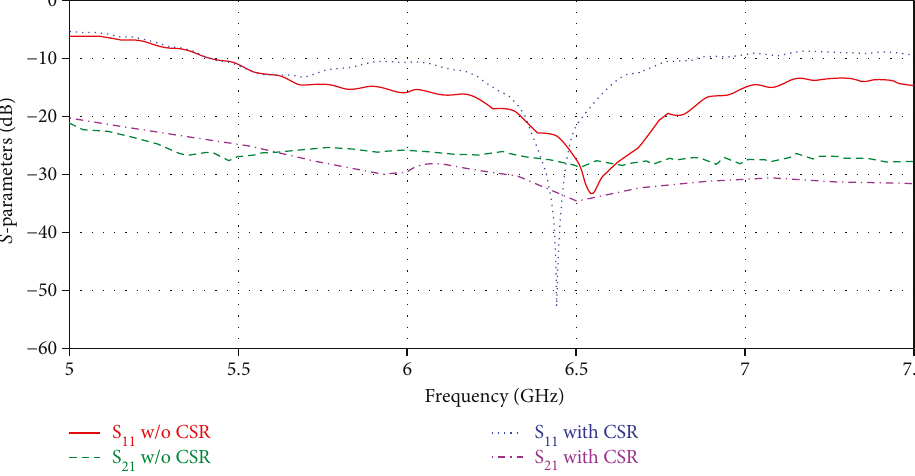
Figure 17: Comparison of the measured S -parameters of the modi fi ed MIMO system with and without CSR